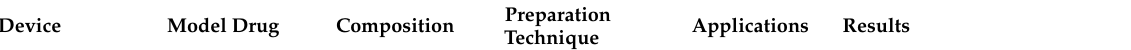
Table 2. Current investigations on PNIPAM-based hydrogels in gene